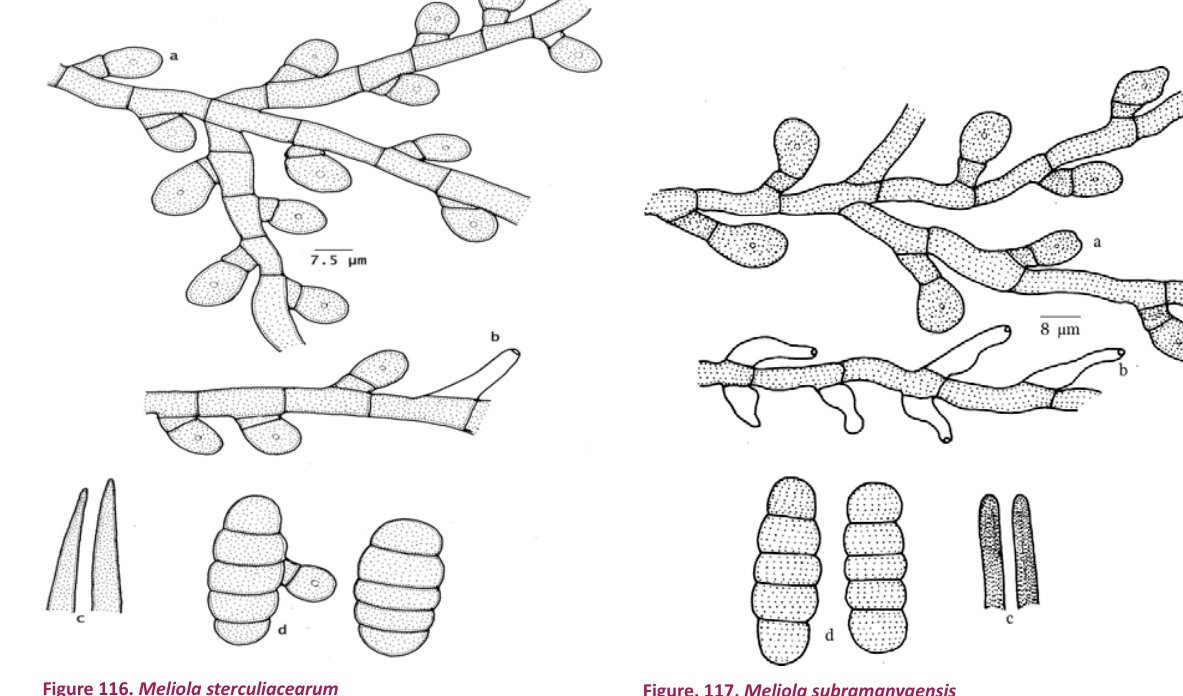
Figure. 117. Meliola subramanyaensis a - Appressorium; b - Phialide; c - Apical portion of mycelial setae; d -